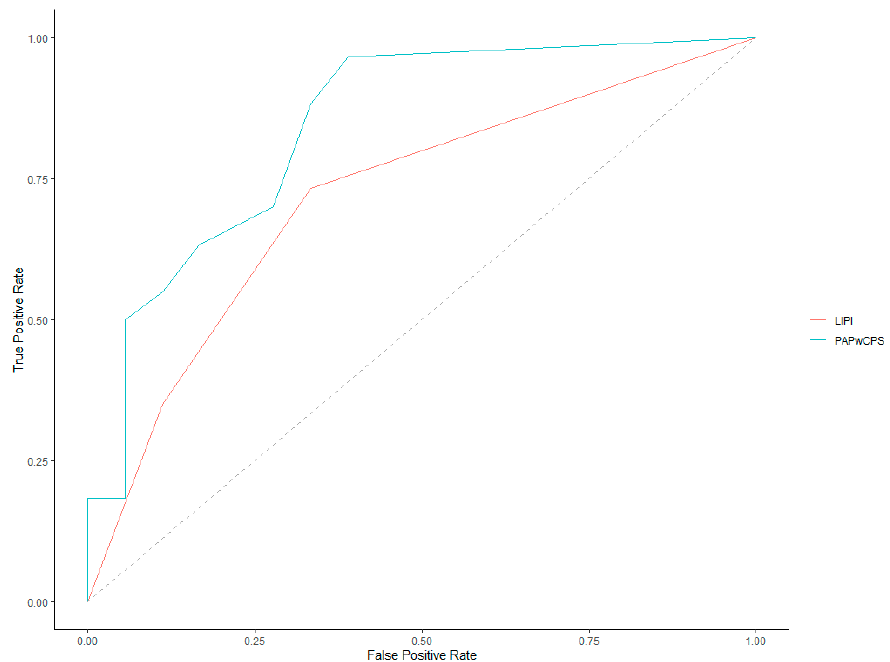
Figure 3. Receiver operating characteristics (ROC) curves for 90-day mortality.